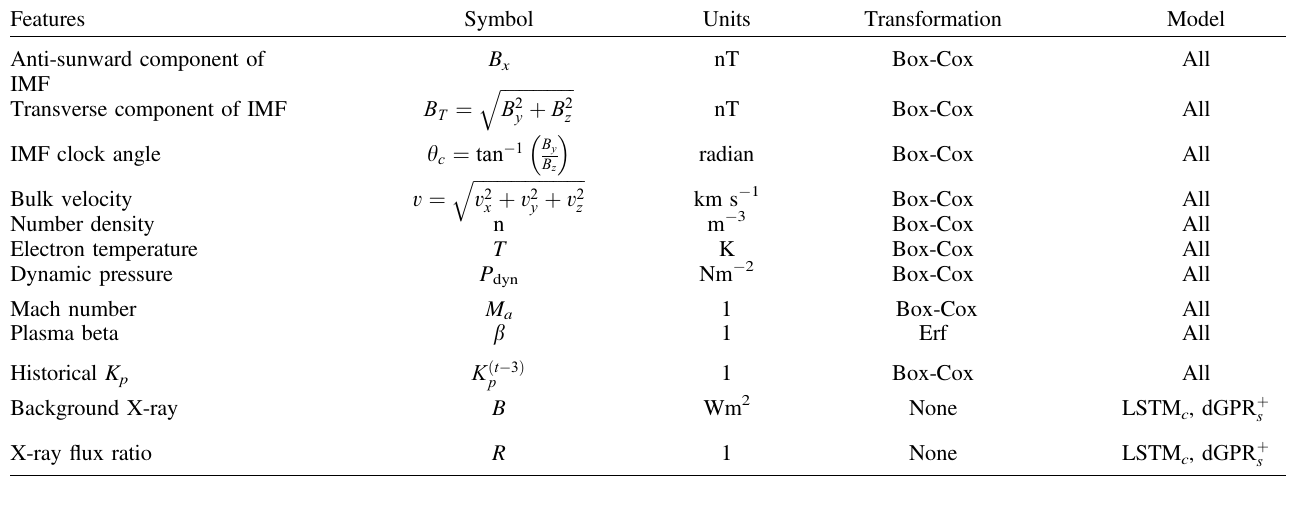
Table 2. Table showing input features of the model, transformations used (if any), and which models use each feature. The given transformation is only used prior to fi tting the Gaussian process model. Box-Cox ? B ( x ) = sgn( x ) (cid:6) log e x and Erf ? erf( x ) =